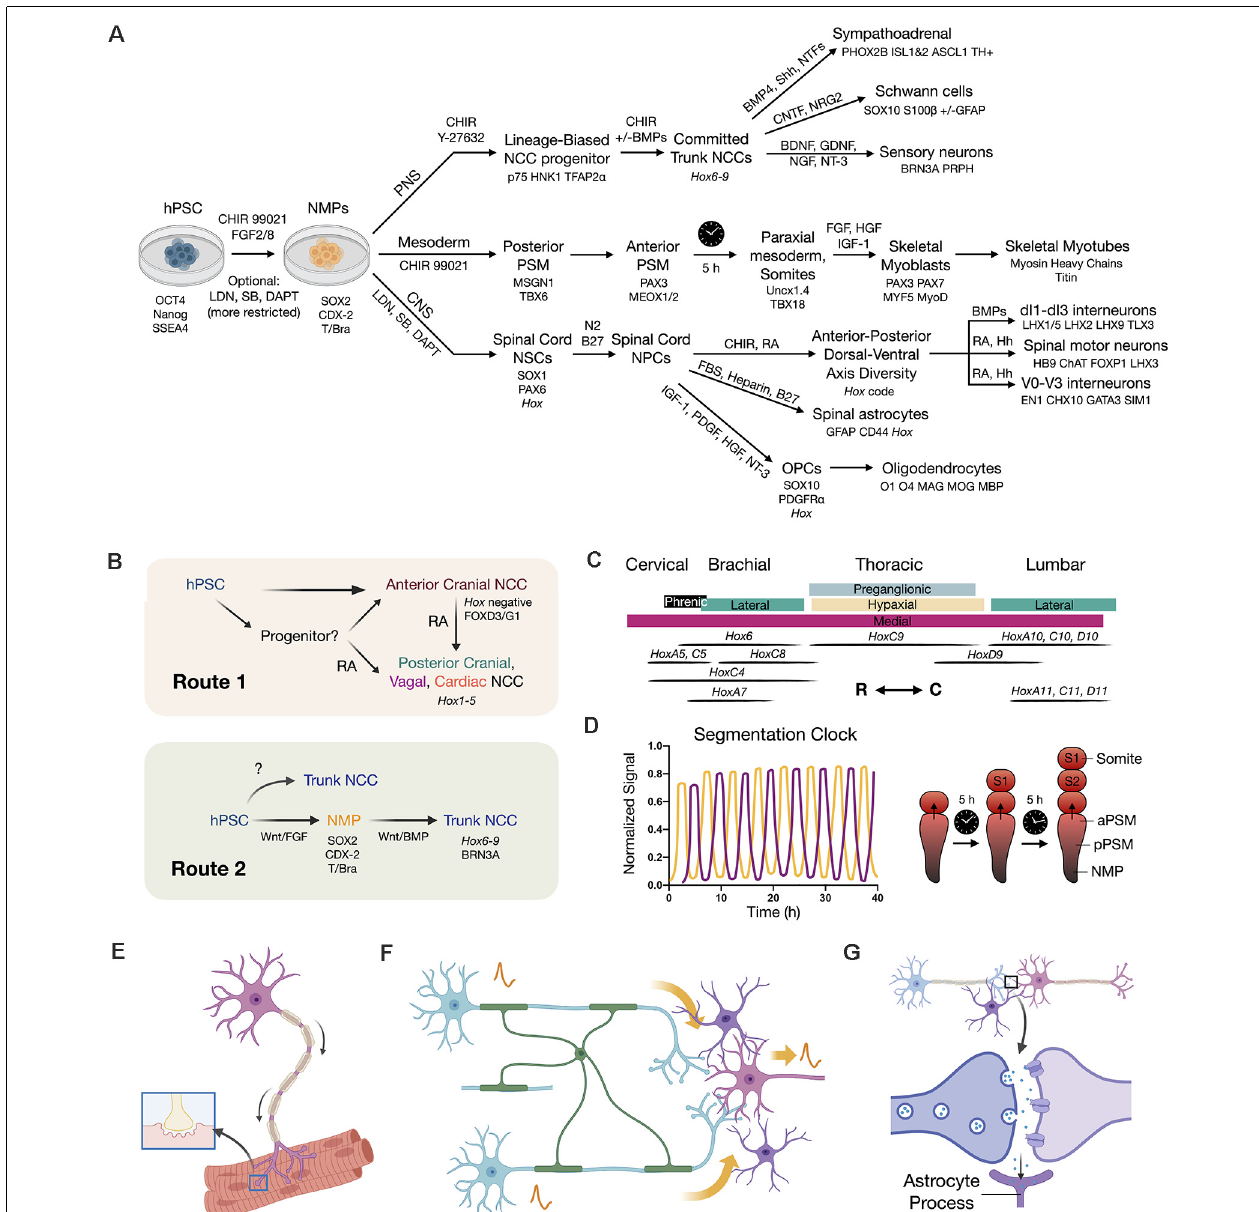
FIGURE 3 | Developmental principles applied to stem cell differentiation. (A) Overview flow chart of human pluripotent stem cell (hPSC) differentiation through NMPs. Key differentiation factors and biomarkers are provided. It should be noted that induced protocols with forced transcription factor expression are also used. Variations in differentiation factors for each lineage have been performed in the literature. (B) Two routes to caudal neural crest cells (NCCs). Route 1 is to caudalize anterior neural crest progenitors (Hox negative) using retinoic acid (RA) to produce posterior cranial, vagal, and cardiac NCCs ( Hox1–5 ). Route 2 is to first generate an NMP intermediate that can in turn produce trunk NCCs with broad axial identity. (C) Hox code of spinal cord motor columns along the neuraxis (Philippidou and Dasen, 2013). R (rostral), C (caudal) directions. (D) Recapitulating the in vivo somite segmentation clock in vitro (Diaz-Cuadros et al., 2020; Matsuda et al., 2020). (E) SMN co-culture with skeletal myotubes to model NMJ function and dysfunction. (F) Neural circuit signal propagation efficiency depends on multicellular interactions between neurons (blue/pink), oligodendrocytes (green), and astrocytes (purple). (G) Tripartite synapse model wherein astrocytes (purple) assist synapse formation, function, and